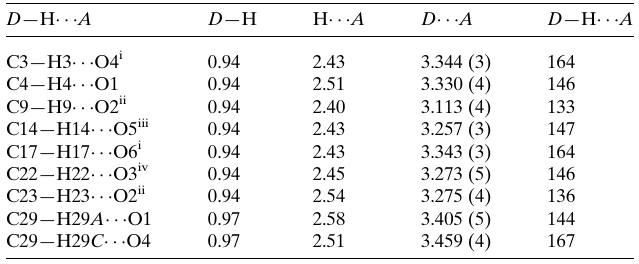
Table 2 Experimental details.